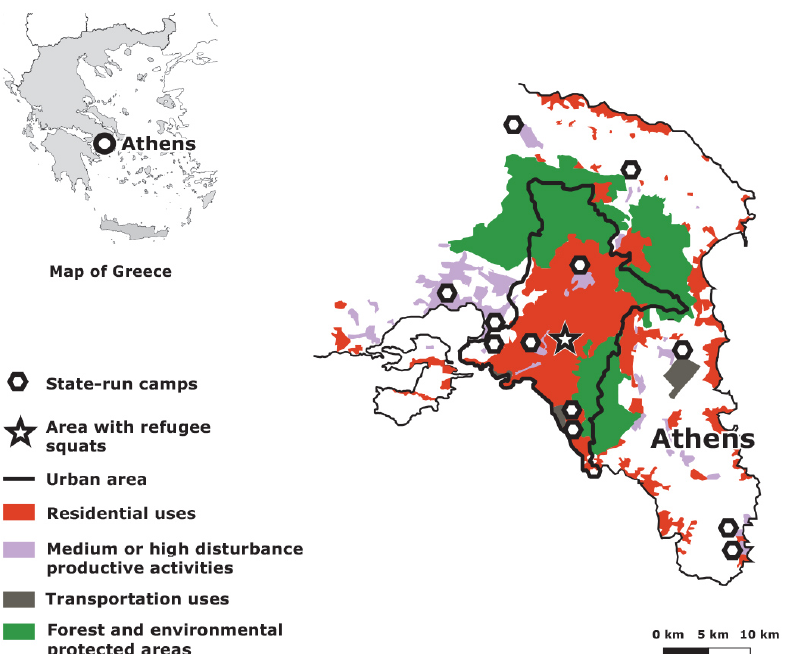
Figure 3. Land use and locations of state-run camps and refugee squats in Athens. Source: Authors, based on the land uses map of Regulatory Urban Plan of Athens and Thessaloniki Metropolitan Areas (2014).